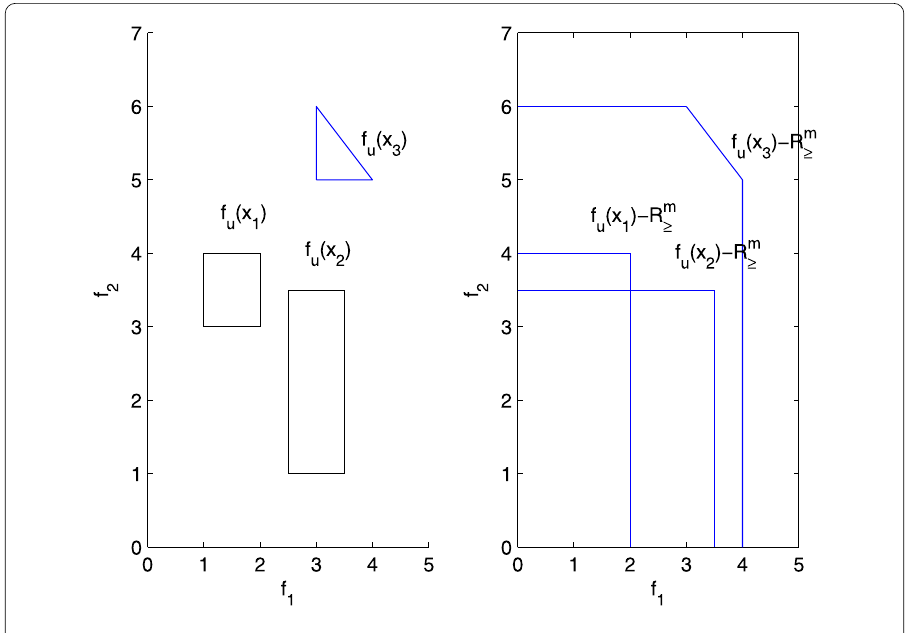
Figure 1 Illustration of robust efficient